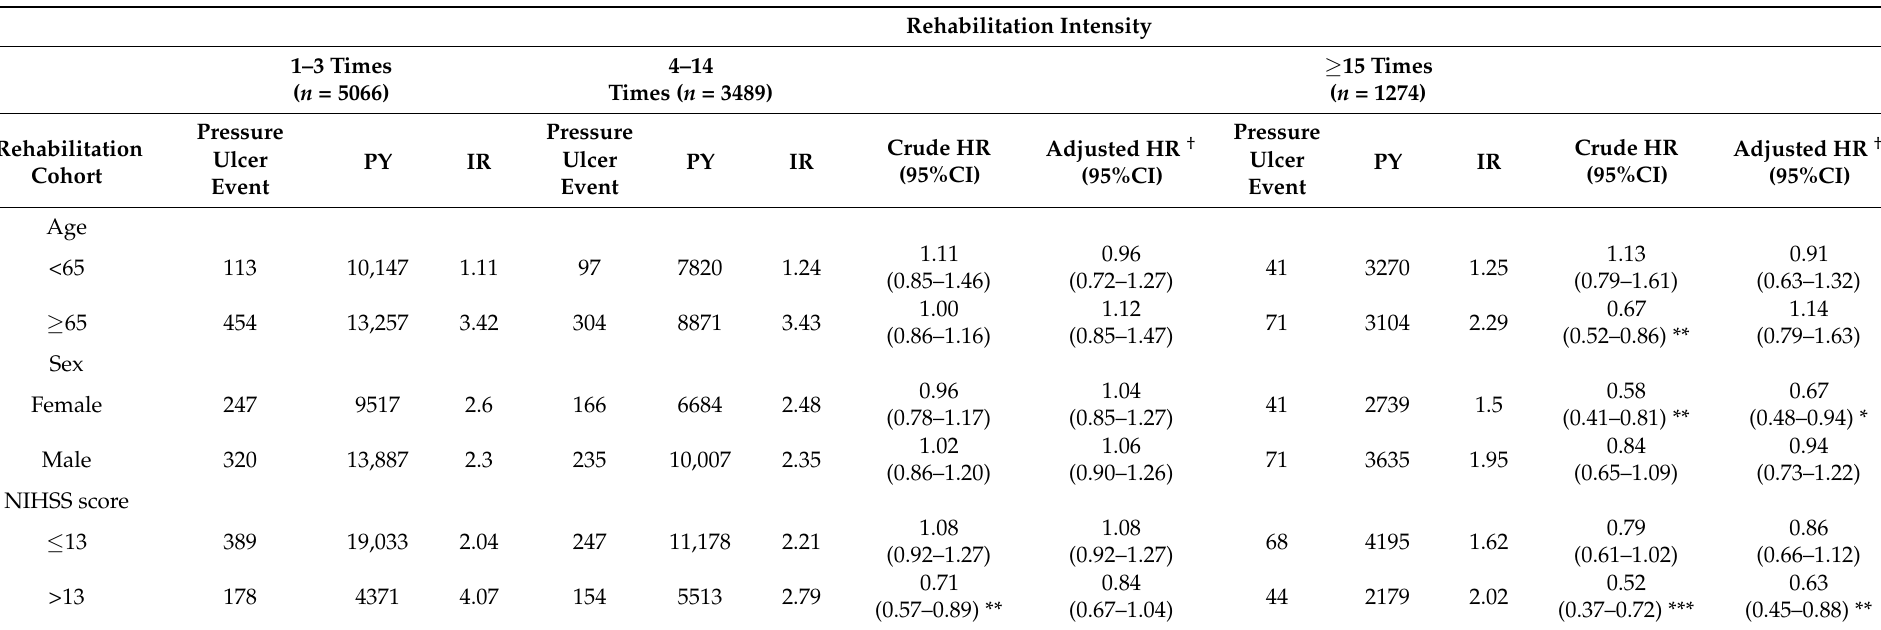
Table 4. Cox regression analyses of age, sex, and NIHSS score associated with pressure ulcer for the rehabilitation cohort by rehabilitation intensity. Rehabilitation